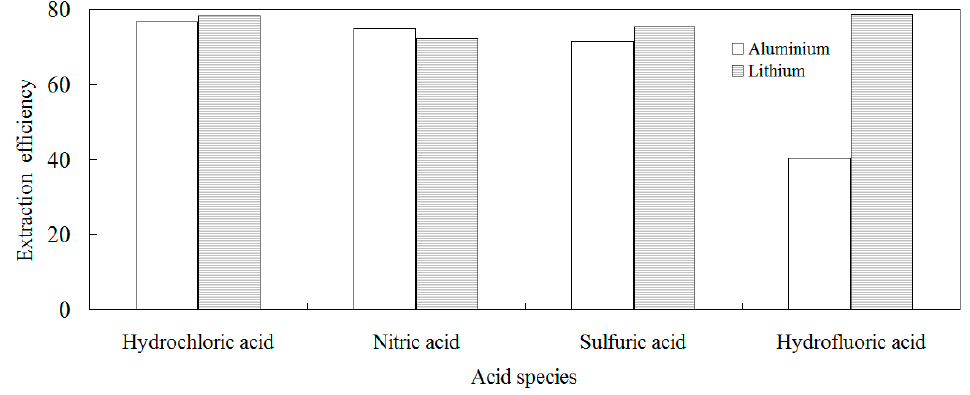
Figure 6. Effects of different acid species on the acid leaching of DCFA (6 mol/L, 120 °C, S/L ratio of 1/20, 4